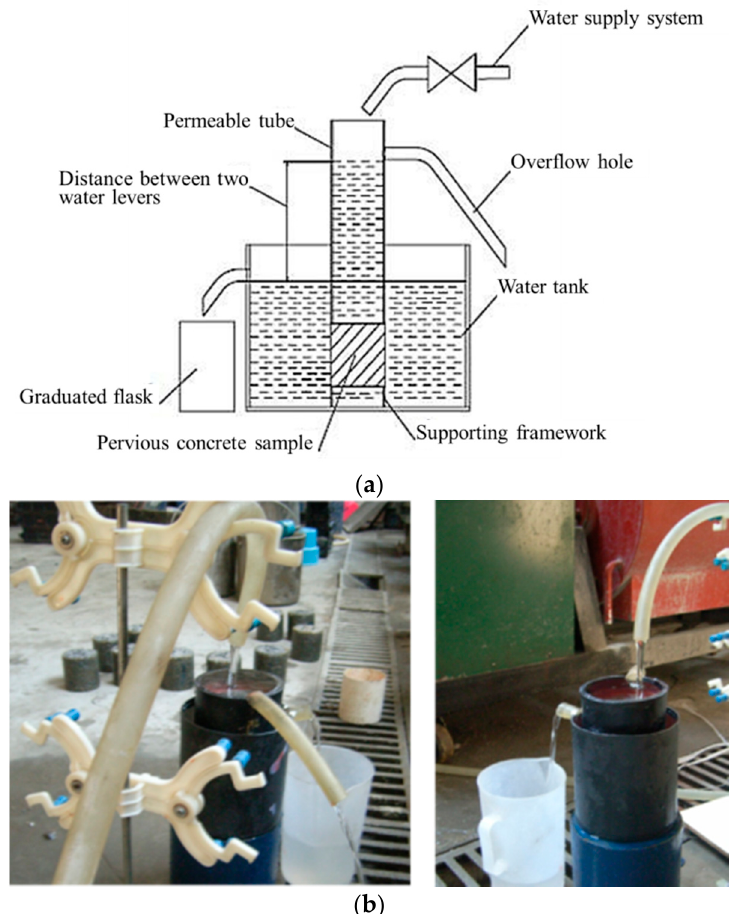
Figure 4. Device of permeable test for vegetation-pervious concrete. ( a ) A schematic drawing of the device; and ( b ) test process using the device.